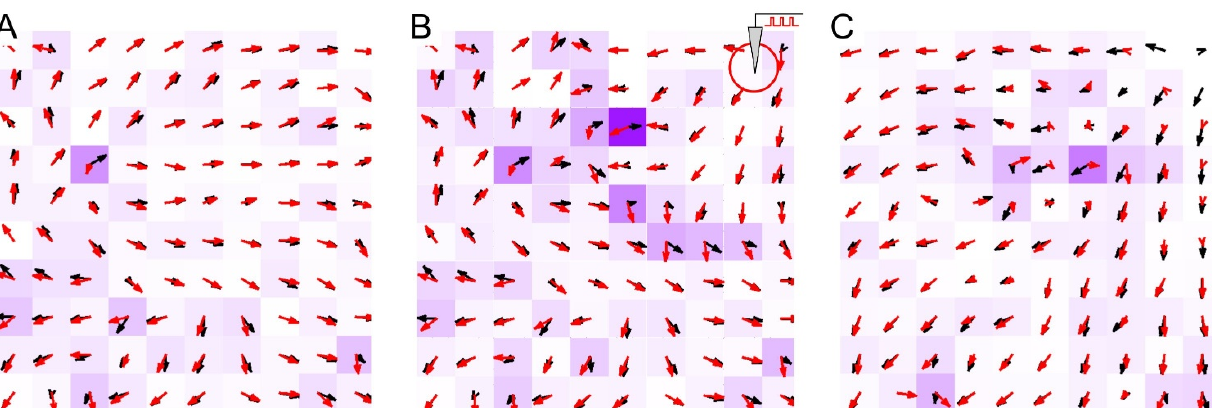
Figure 3. Comparison of the vector fields of anatomical (black arrows) and functional (red arrow) connections during neuronal activity before ( A ), during ( B ), and after ( C ) a period of long-term local stimulation. The intensity of the magenta color of the cells is proportional to the field difference.